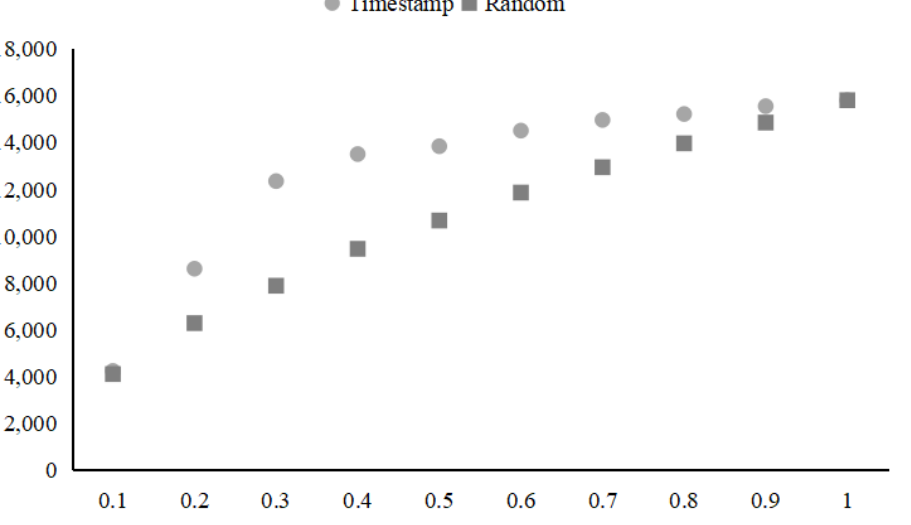
Figure 9. Log types distribution on HDFS dataset.